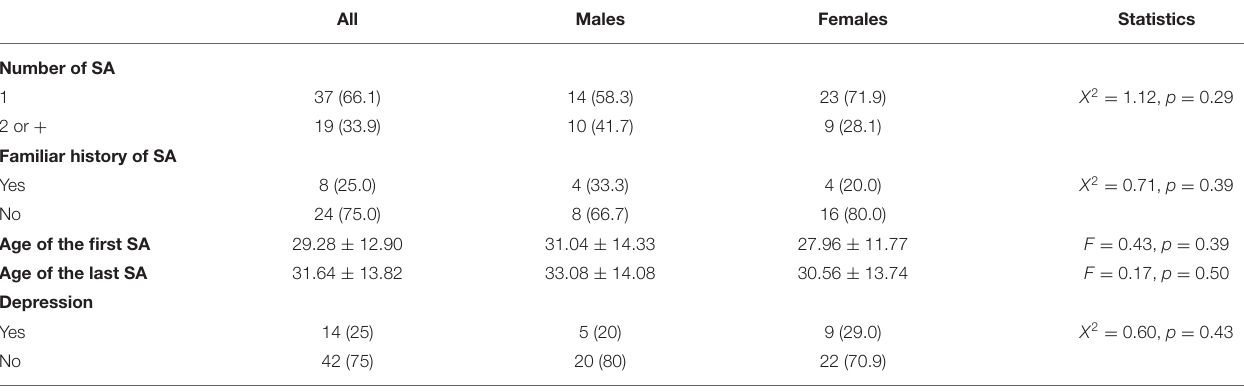
TABLE 3 | Characteristics of suicide attempt among males and females in Mexican population. All Males Females